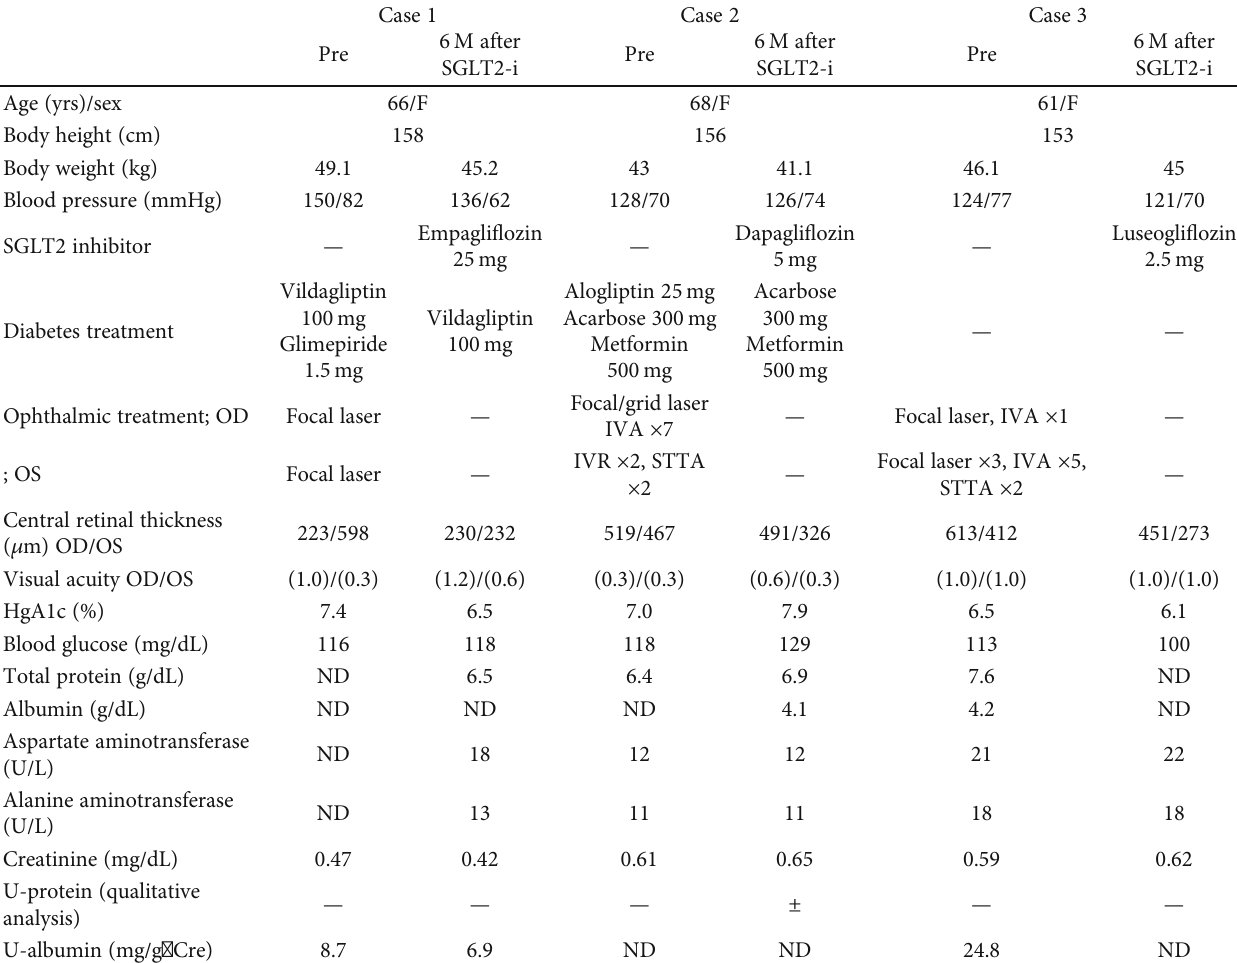
Table 1: Summary of three cases of DME pre and 6 months (M) after the SGLT2-i